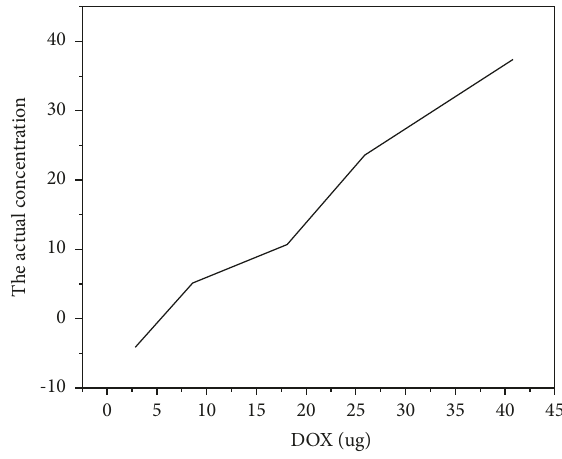
Figure 2: Standard curve of DOX.